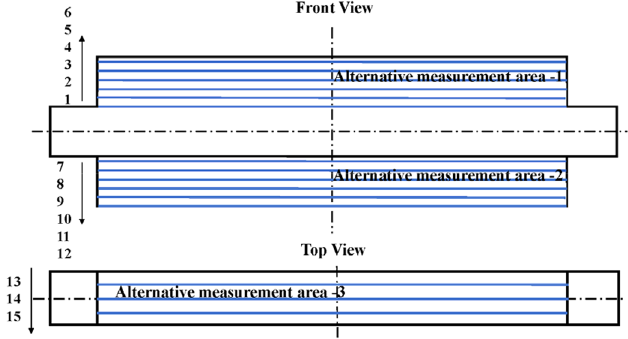
Fig. 5. Optical fi ber sensor optimization (cid:2) alternative